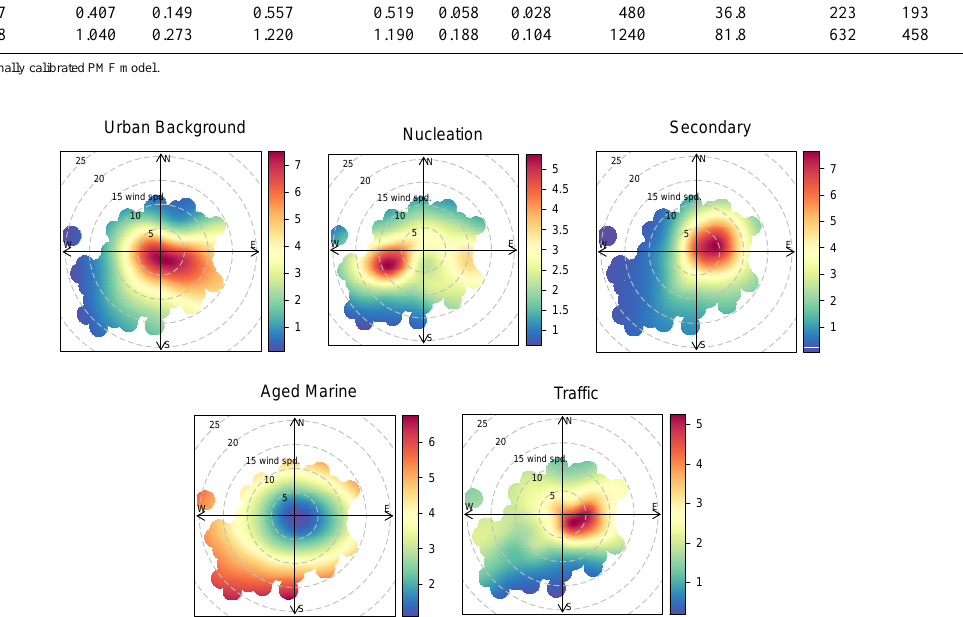
Figure 11. Polar plots showing how the PMF factors derived from the combined chemical composition–NSD data set are affected by the daily vector average wind velocity and direction (units: G values (arbitrary units) and wind speed (ms − 1 )